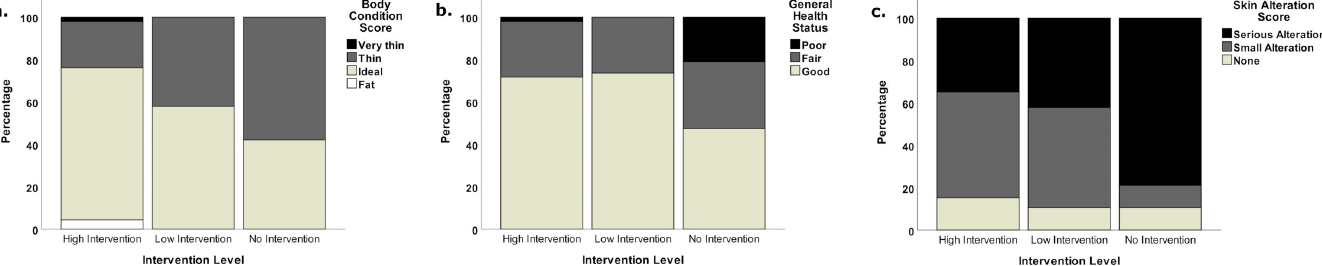
Fig 3. Stacked bar charts showing the percentage distribution of body condition scores, general health status scores and skin alteration scores of riding equids in veracruz across intervention levels.